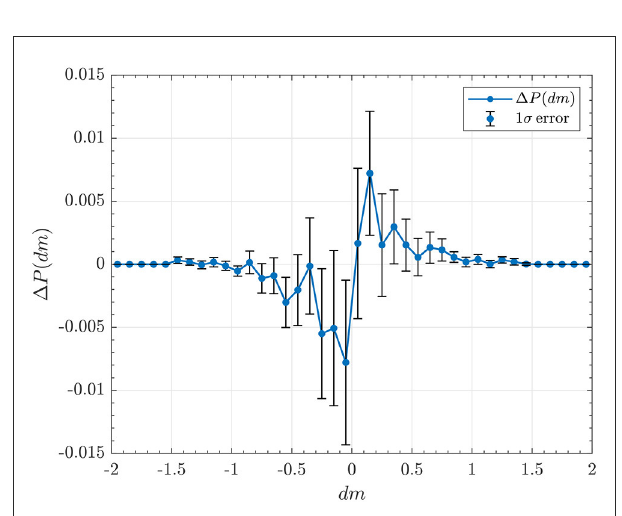
FIGURE6 The dependence of the differences in cumulative magnitude distributions 1 P ( dm ) on the size difference dm between the magnitudes of subsequent events. The mean of the 1,000 reshuffled cataloge is considered for 1 m * . The error bars correspond to one standard